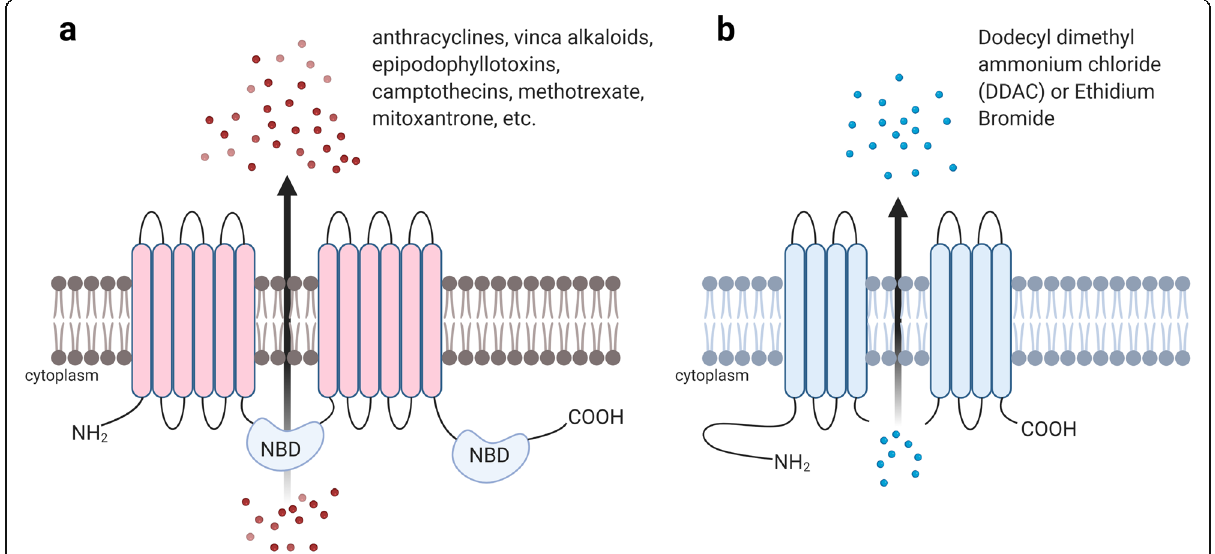
Fig. 4 Comparative representation P-gp and EmrE. a ABCB1 (P-gp) transporter, one of the most frequently overexpressed transporters in human cancers. ABCB1 confers resistance to anthracyclines, vinca alkaloids, epipodophyllotoxins, camptothecins, methotrexate, mitoxantrone, etc. b EmrE transporter of Escherichia coli , belonging to SMR family of drug efflux transporters. EmrE confers resistance to dodecyl dimethyl ammonium chloride (DDAC) or Ethidium